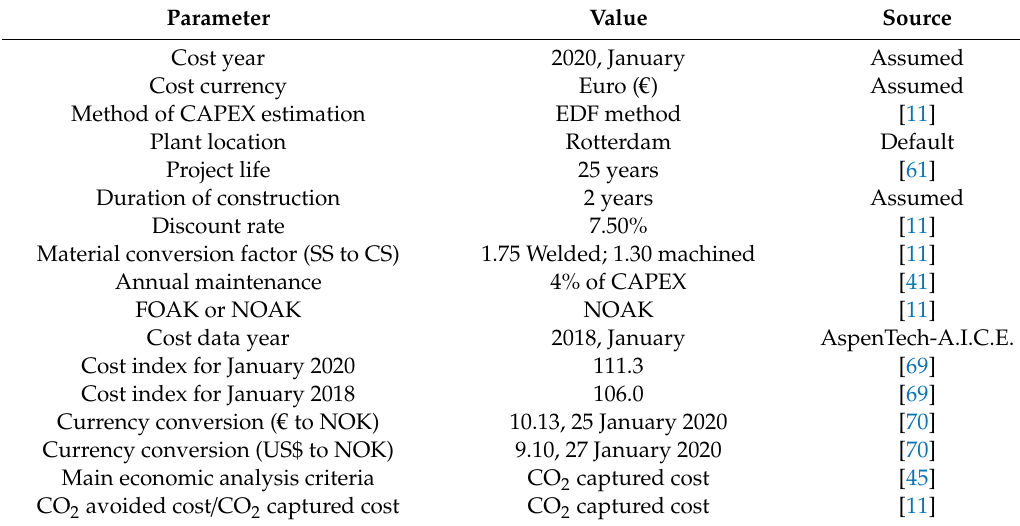
Table 3. Assumptions for capital cost